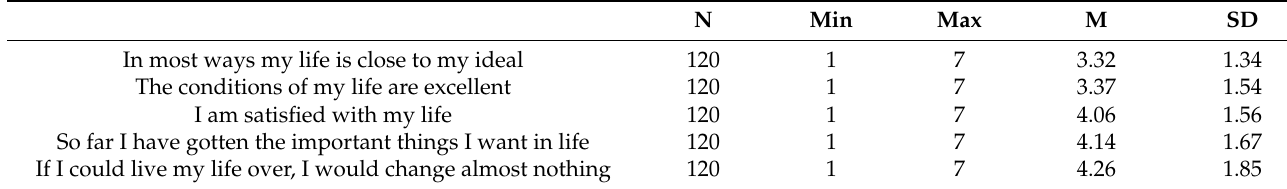
Table 3. Satisfaction with life assessed using the SWLS